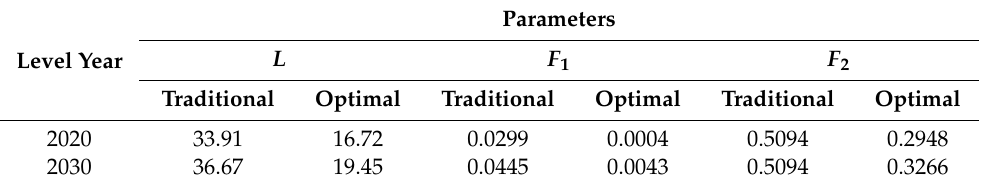
Table 4. The value of objective function between traditional and optimal